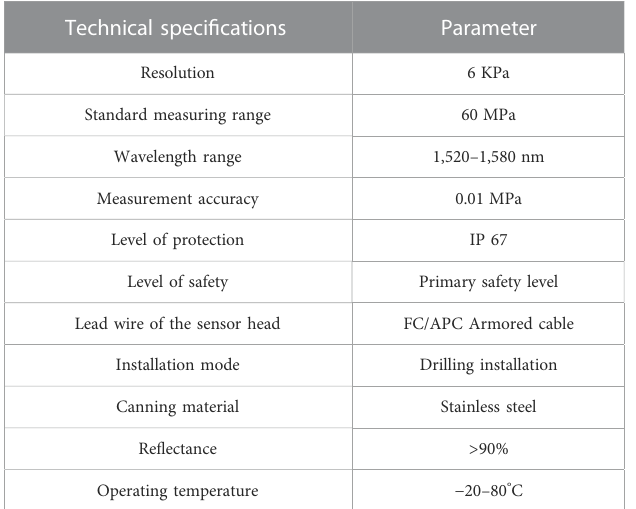
TABLE 2 Main technical parameters of the CS-FBG borehole stress meter.